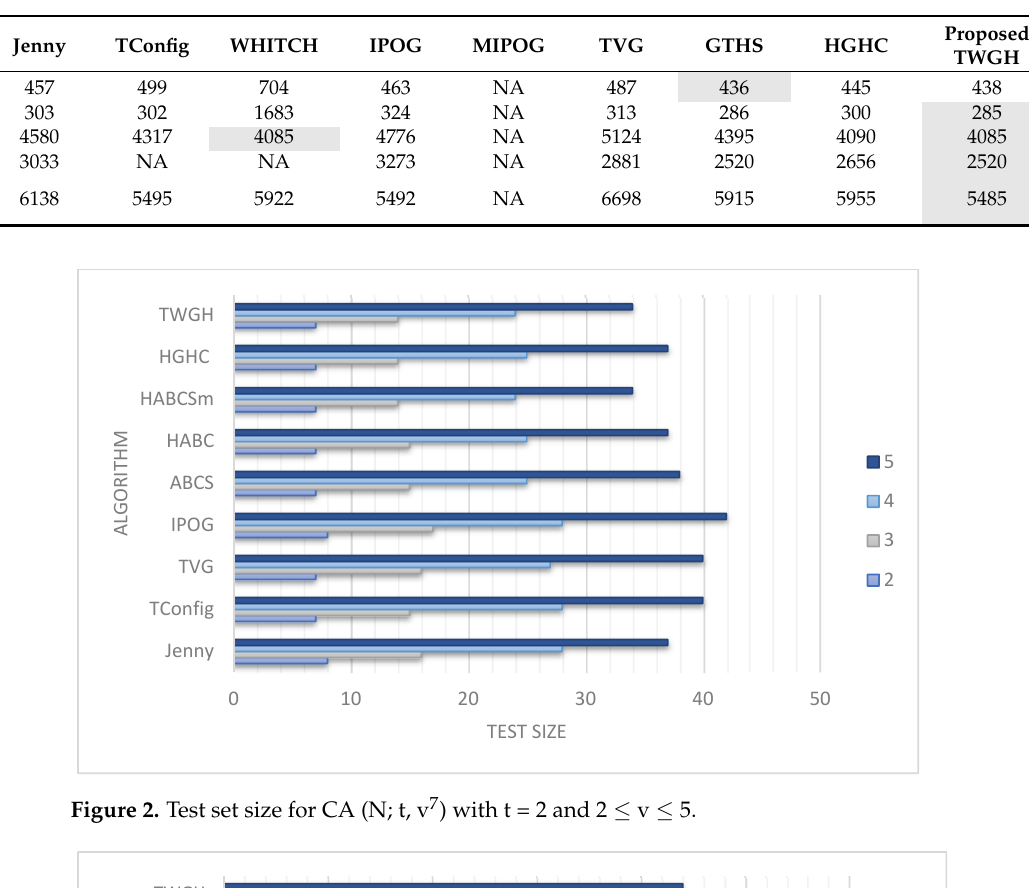
Figure 2. Test set size for CA (N; t, v 7 ) with t=2 and 2 ≤ v ≤ 5.